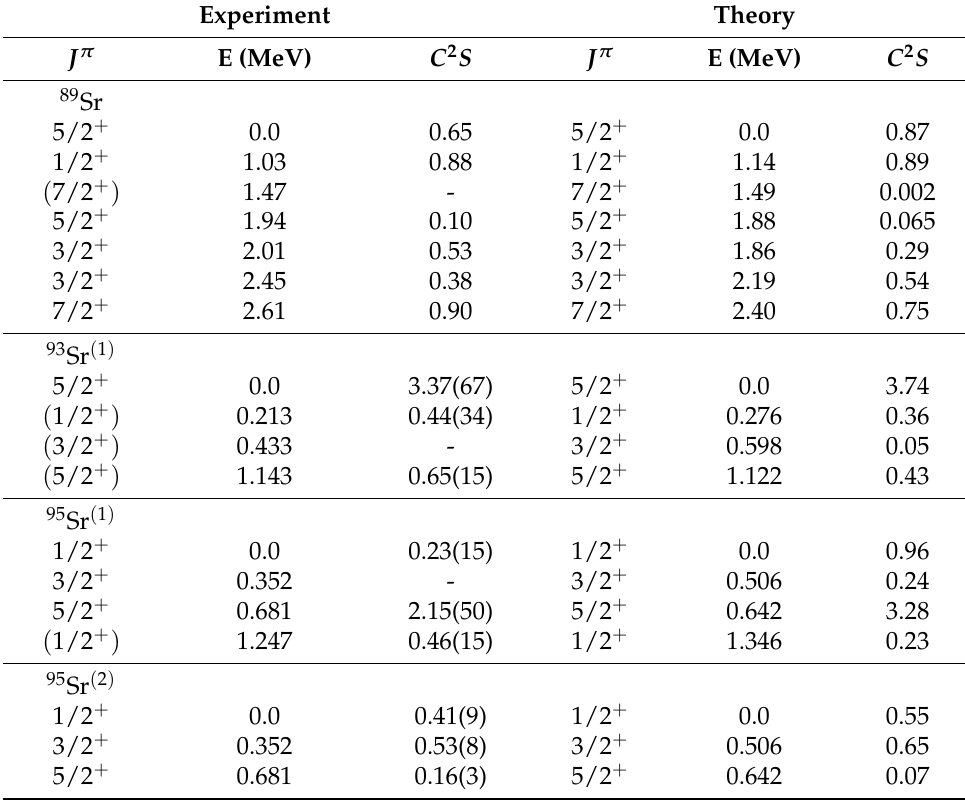
Table 1. Spectroscopic factors computed for 89,93,95 Sr nuclei compared to the experimental data from [30] in 89 Sr, Table II of [21] (1) and Table IV of [22] (2). See the text for more